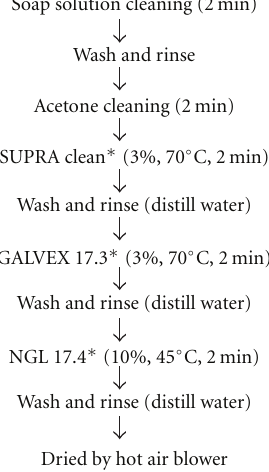
Figure 1: As used cleaning cycle.